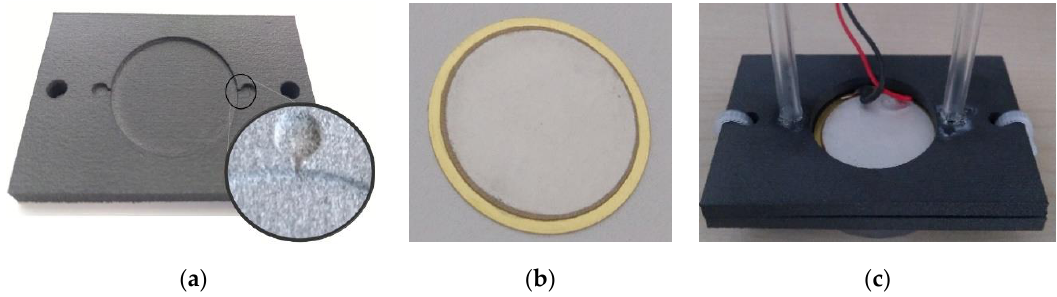
Figure 11. Pump prototype: ( a ) 3D printed bottom closure, ( b ) the piezoelectric actuator, ( c ) assembled and sealed pump.